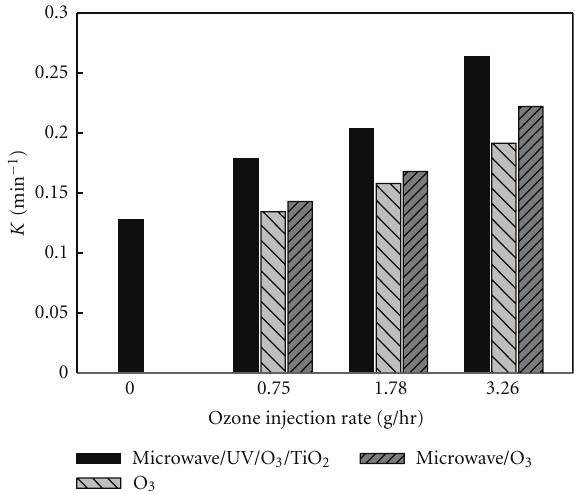
Figure 3: E ff ect of TNT powder dosages on decomposition of RB.